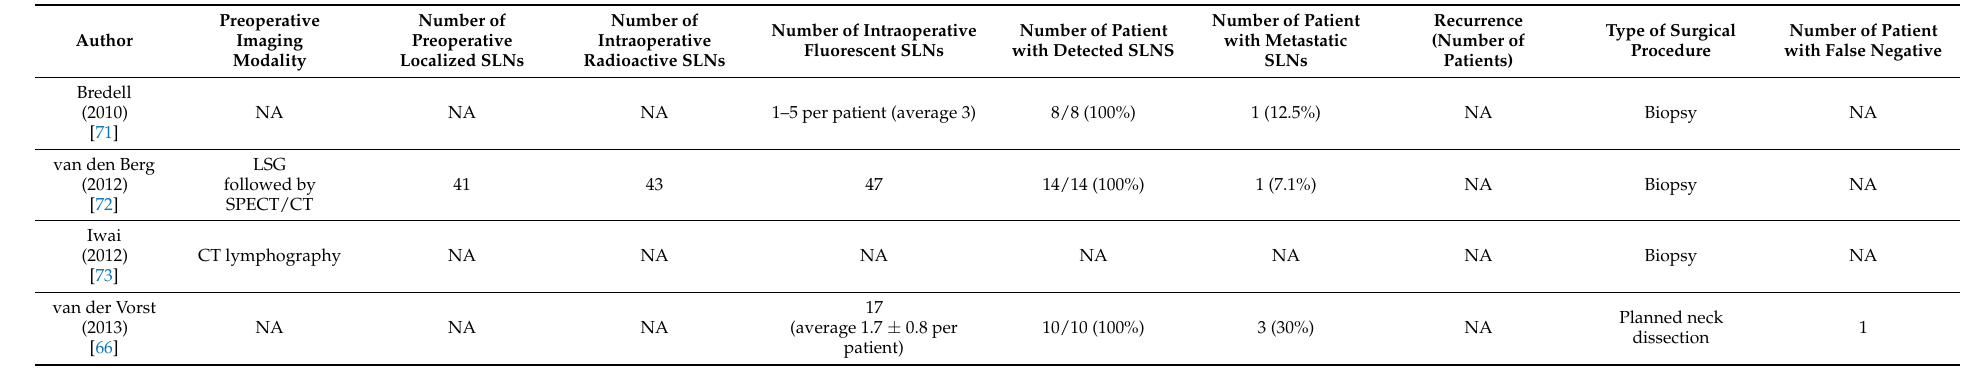
Table 2. Efficacy of previous clinical